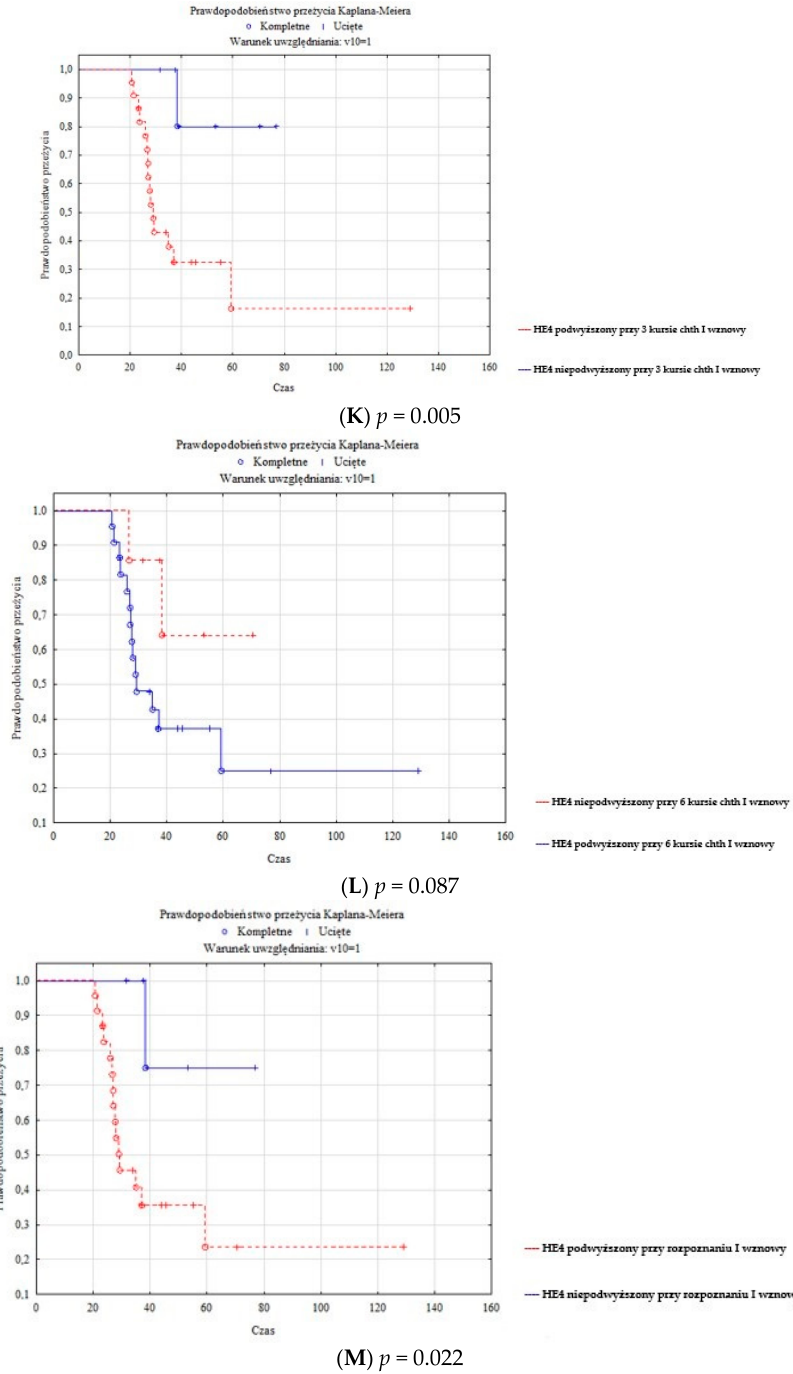
Figure A2. Kaplan–Meier survival curves for progression-free survival 2 (PFS2), the time from disease diagnosis to diagnosis of 2 relapses, according to HE4 concentration. ( A ) Elevated serum HE4 concentration at the time of OC diagnosis; ( B ) HE4 above 500.0 pmol/L; ( C ) HE4 > median at the time of OC diagnosis; ( D ) normalization of HE4 values after the third course of first-line chemotherapy; ( E ) normalization of HE4 values after the last course of first-line chemotherapy; ( F ) HE4 decrease >50% after PDS; ( G ) HE4 decrease >50% after the third course of first-line chemotherapy; ( H ) HE4 normalization after PDS; ( I ) HE4 normalization before IDS; ( J ) decrease of 50% in HE4 concentration before IDS; ( K ) increased HE4 at first OC recurrence diagnosis; ( L ) increased HE4 after the third course of second-line chemotherapy; ( M ) increased HE4 after the last course of second-line